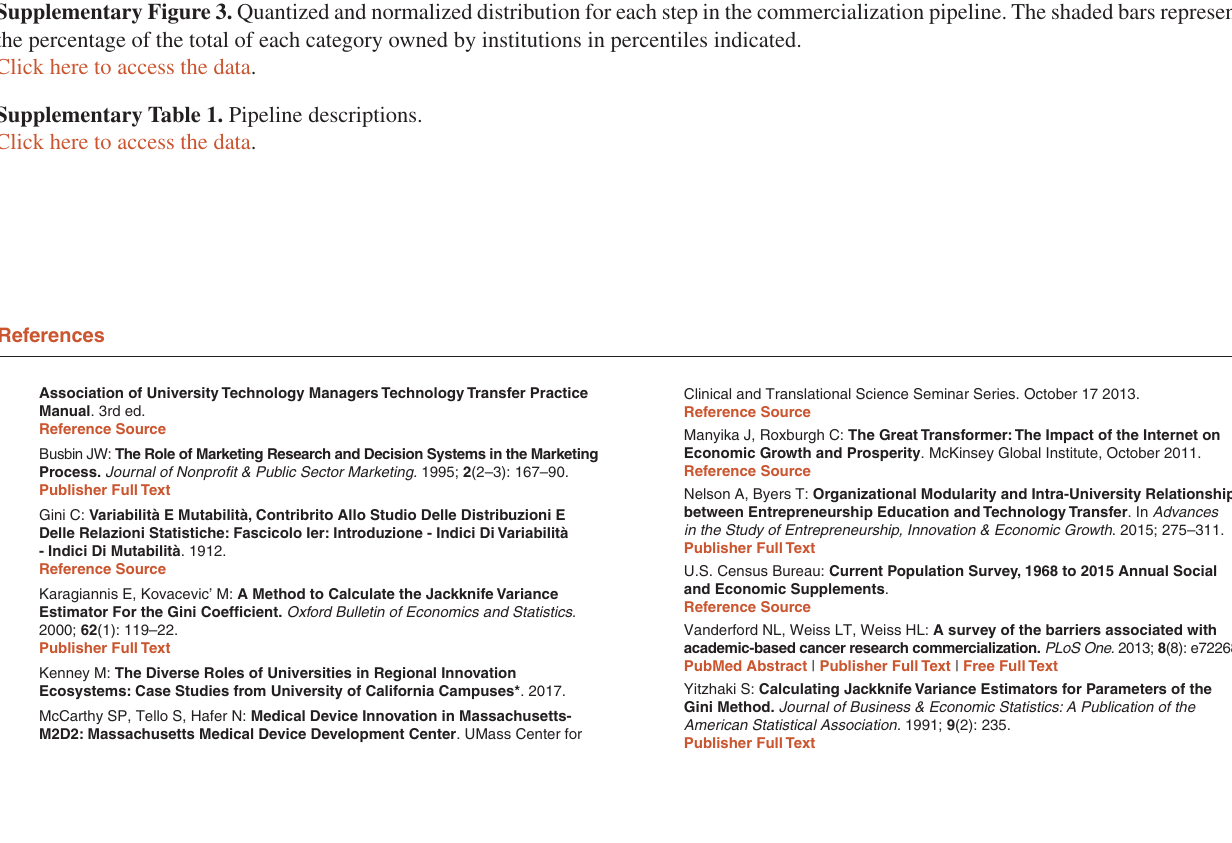
Supplementary Figure 1. Histograms of each step in the commercialization pipeline shown in Figure 1. Insets show cumulative distribu- tions, with shaded rectangles indicating the number of institutions necessary to reach 80% of total activity. Click here to access the data. Supplementary Figure 2. Histograms of each step in the commercialization pipeline shown in Figure 1 with a log x-axis. Note that the x-axes is on a log scale and therefore the significant skew in the distribution is not immediately apparent. Click here to access the data. Supplementary Figure 3. Quantized and normalized distribution for each step in the commercialization pipeline. The shaded bars represent the percentage of the total of each category owned by institutions in percentiles indicated. Click here to access the data. Supplementary Table 1. Pipeline descriptions. Click here to access the